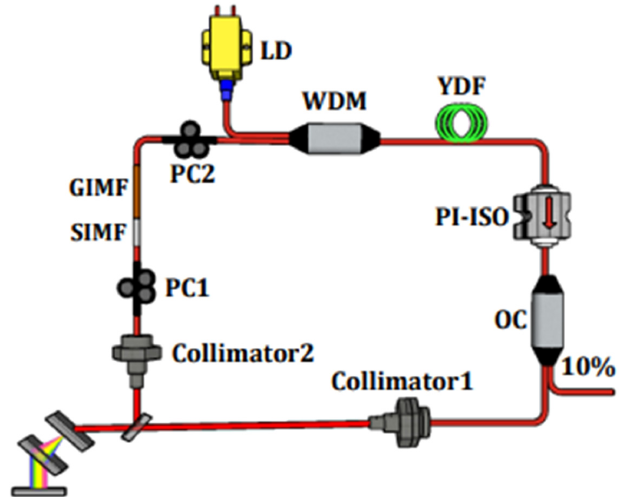
Figure 1. Schematic diagram of the Yb ‐ doped fiber laser.